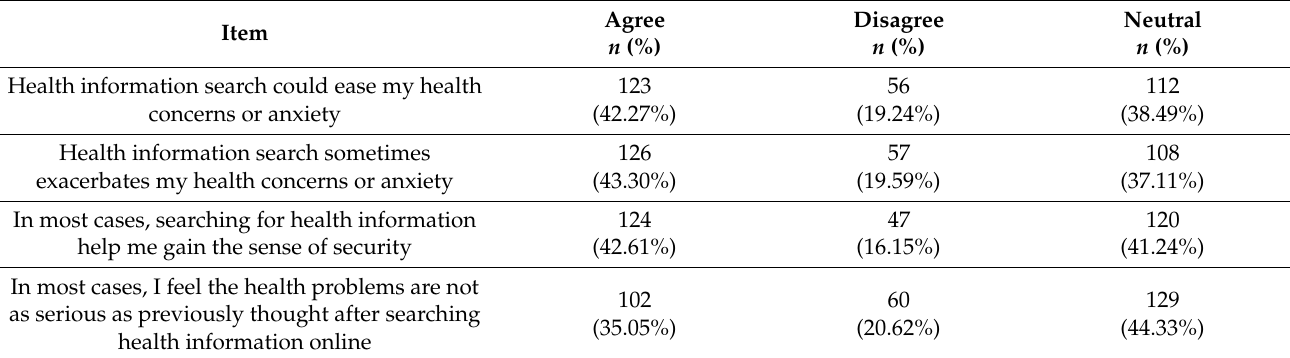
Table 7. Functions of health information